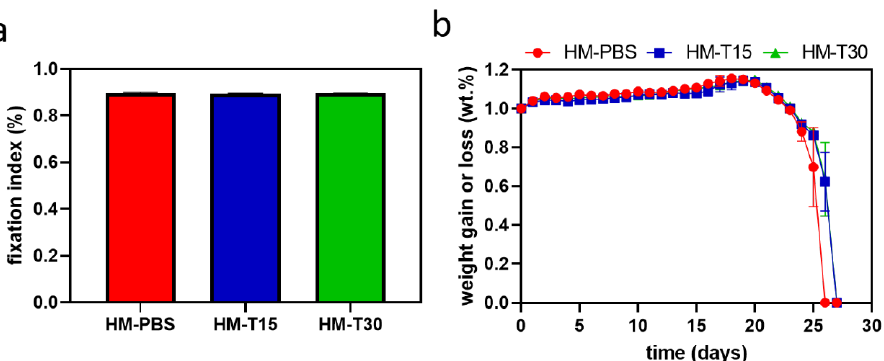
Figure 3. Fixation index (%) reflecting the cross-linking degree of HM, HM-T15, and HM-T30 ( n = 9, p > 0.05). ( a ) Relative long-term immersion demonstrated variation in the weight gain or loss of PBS among the samples ( n = 6). ( b ) One-way ANOVA.